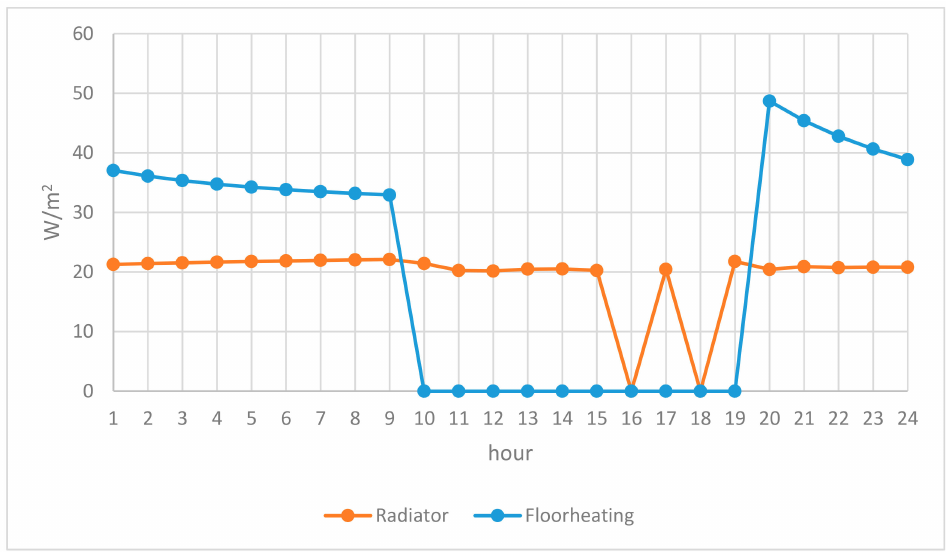
Figure 6. Supply heating demand profile for the studied BBR building with radiator and floor heating system on the design